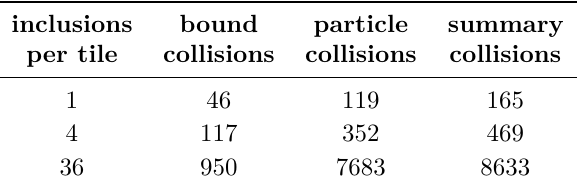
Table 3. Computer demands – number of collisions of